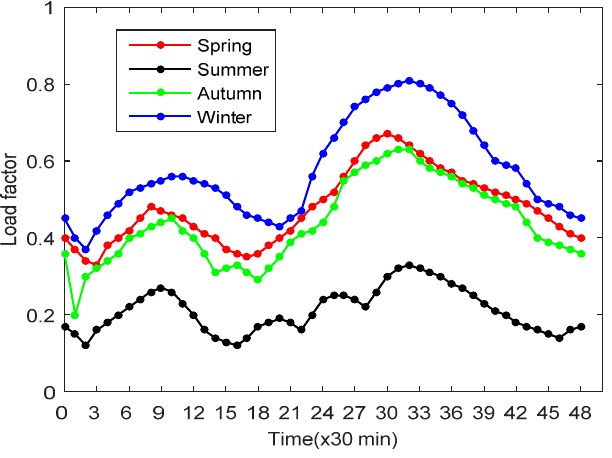
Figure 5. The typical timing characteristic curves of wind power output for the four seasons.